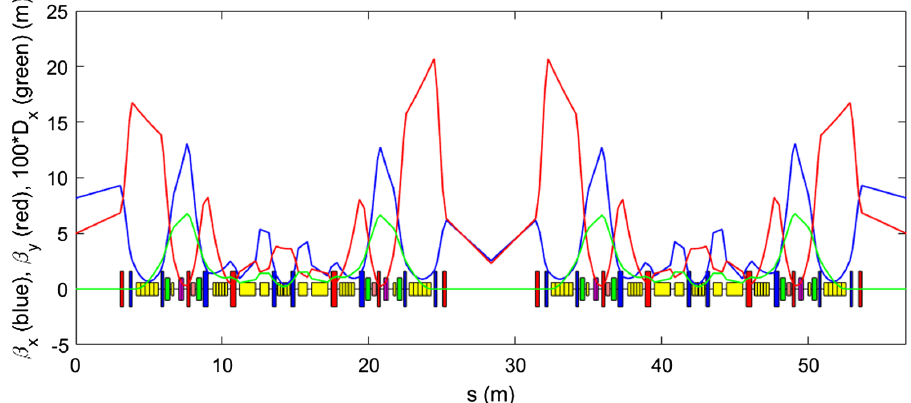
FIG. 8. Layout and optical functions of a period with two 7BAs in the lattice of the HEPS.